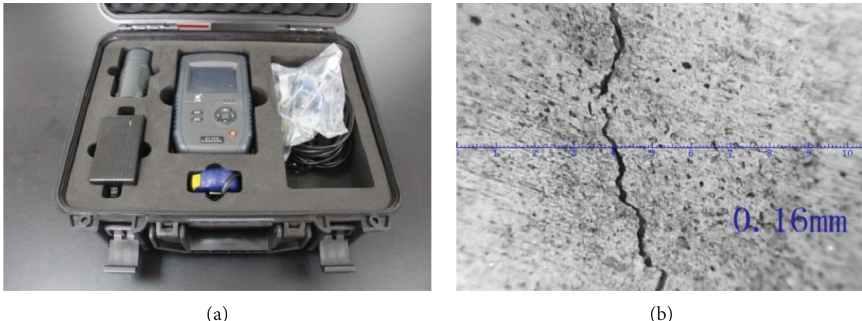
Figure 14: Visual crack width measurement. (a) KON-FK (B) crack width observation instrument. (b) Crack measurement.